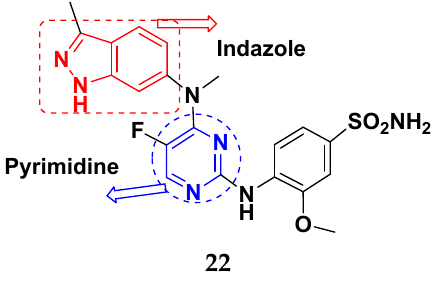
Figure 25. A pyridine hybrid ( 21 ). Boloor et al. (2012) synthesized and patented pyrimidine-indazole based hybrids as VEGFR2 inhibitors. Compound 22 showed potent activity with an IC 50 < 50 µ M. Further- more, the lead compound 22 (Figure 26) was evaluated in an endothilian cell proliferation assay where it displayed activity withIC 50s of 1-200 nM [73].